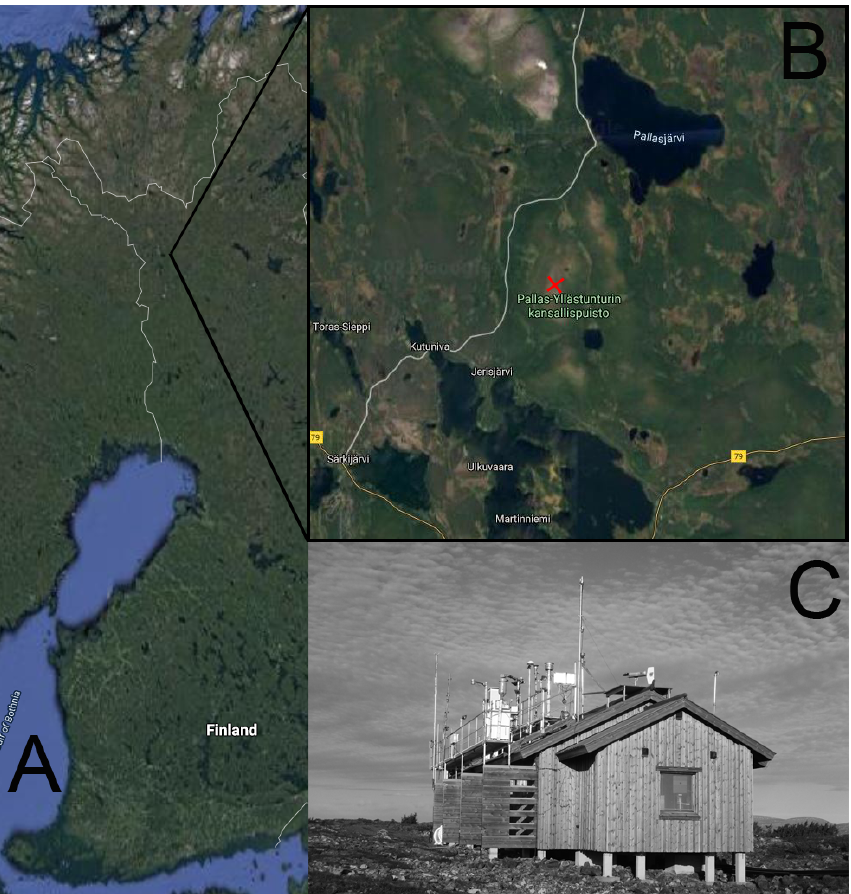
Figure 1. (a) Map of Finland showing the location of the field station, and (b) map of the wider Pallas area showing the location of the Sammaltunturi station (red cross) (© Google Maps). (c) The Sammaltunturi measuring station during